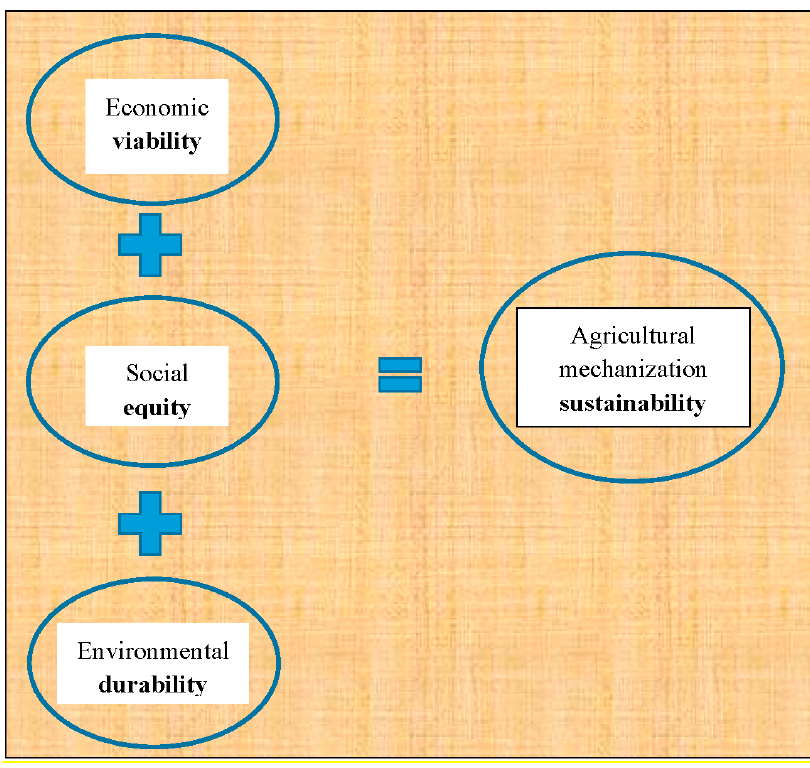
Figure 1. Agricultural mechanization—the principles of sustainability ( source: after FAO [23]) .